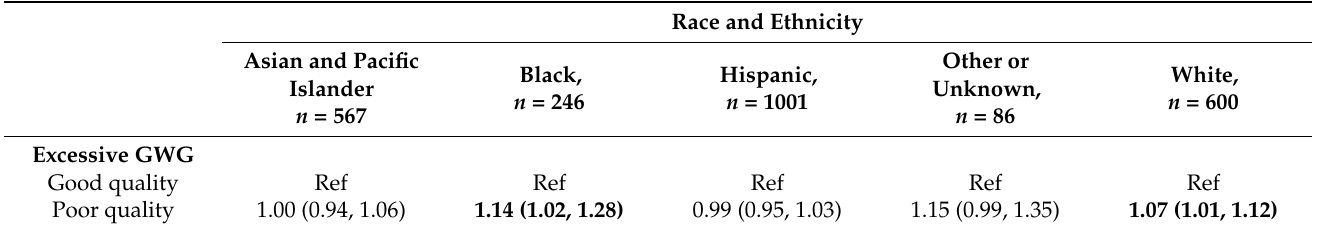
Table 4. Adjusted * relative risk of excessive gestational weight gain rate by diet quality defined by HEI-2010, stratified by race and